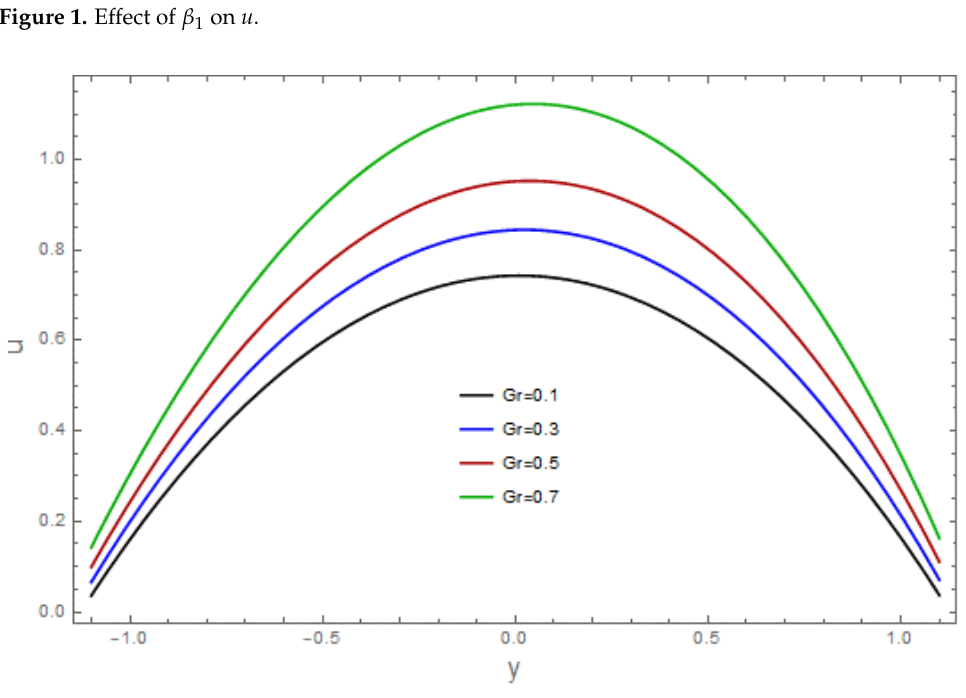
Coatings 2023 , 13 , x FOR PEER REVIEW